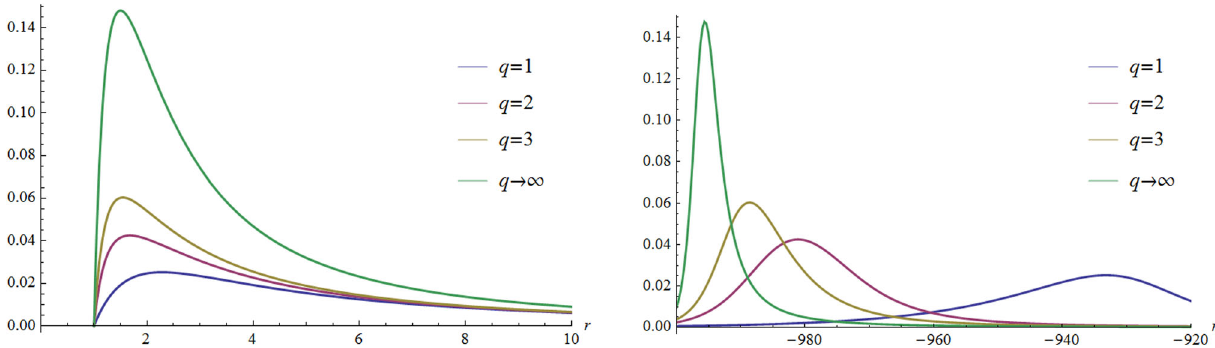
Fig. 3 The graphical representation of the reduced potential V /( l ( l + 1 )) as a function of the radial coordinate r (left panel) and the tortoise coordinate r ∗ (right panel) for P = 2 μ = 1, q = 1 , 2 , 3 and the limiting case q →